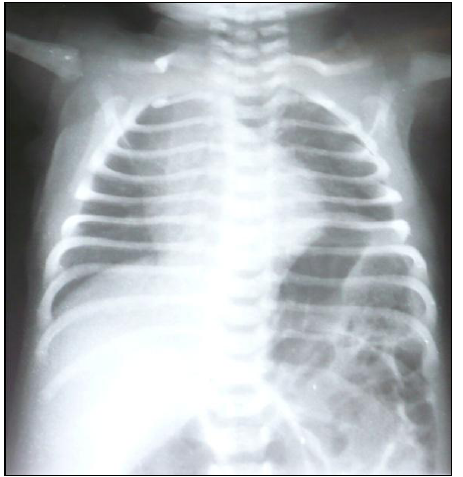
Figure 2: Elevated left hemidiaphragm in the same